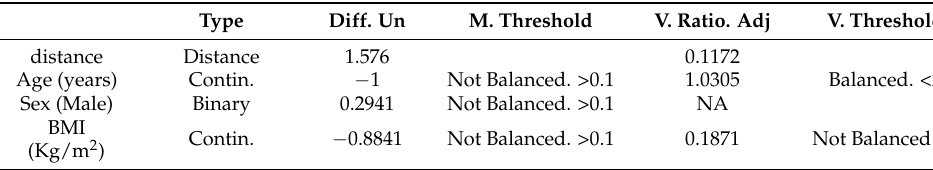
Figure 2. Kaplan Meir curves on relapse of tumor according to the type of surgery. A propensity score matching balance table is included in Table 2. Table 2. Propensity score matching balance table. Type